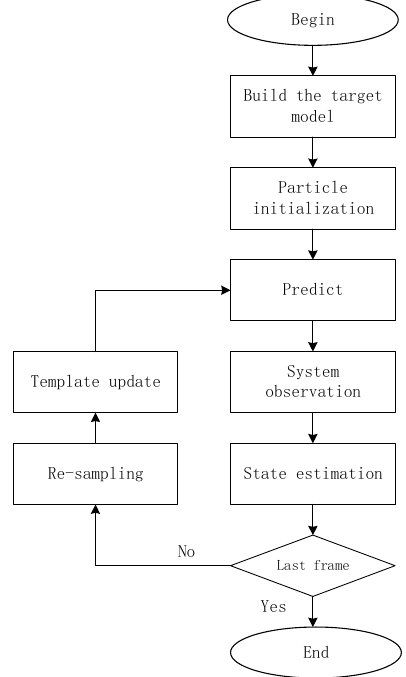
Figure 1. Traditional particle filter algorithm flow.